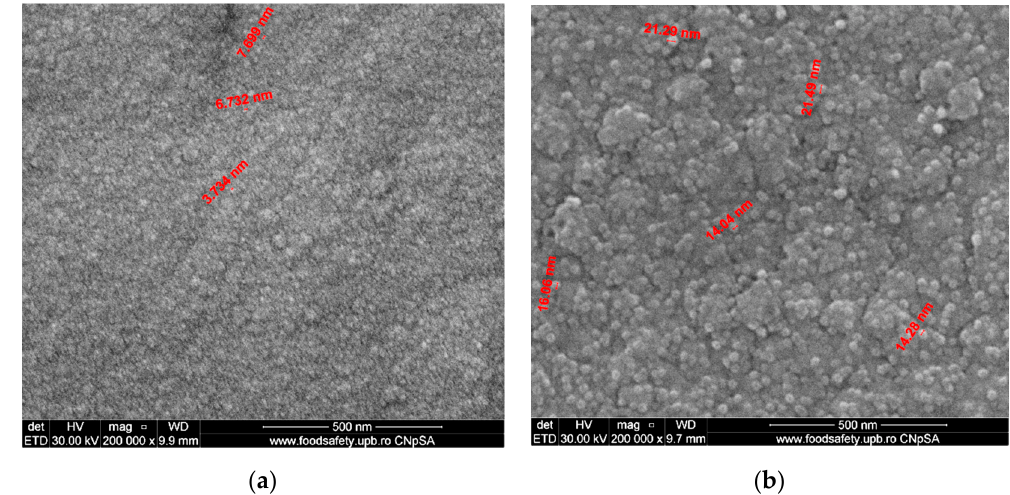
Figure 2. FE-SEM analysis of Co-Cr samples fabricated via DMLS and coated with a thin film of Ta 2 O 5 produced by an e-gun for: ( a ) sample S1 with post-treatment; ( b ) sample S2 without post-treatment (200,000 × ).